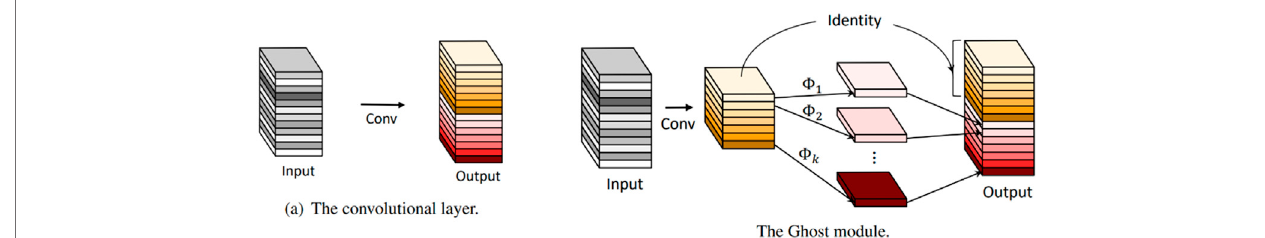
FIGURE 3 | Ordinary convolution operation and Ghost module operation.